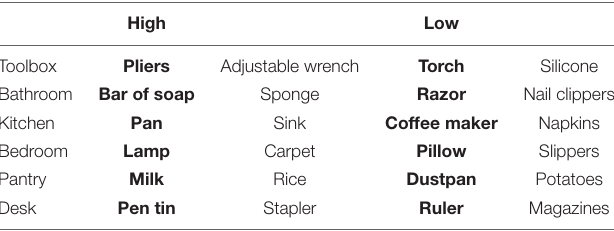
TABLE 1 | Contagion items: The main contagion items for each scene highlighted in bold.